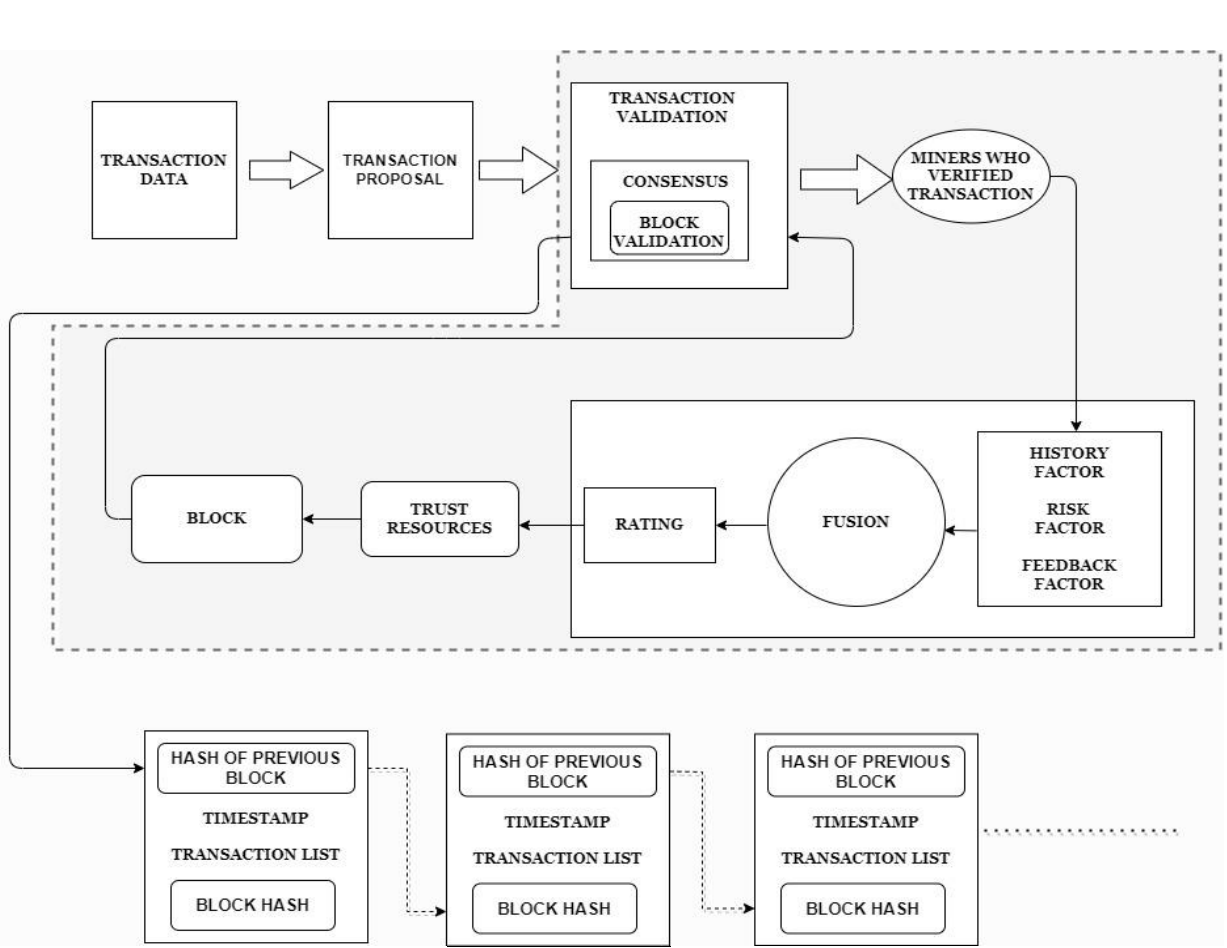
Figure 3.1 . Proposed Architecture and